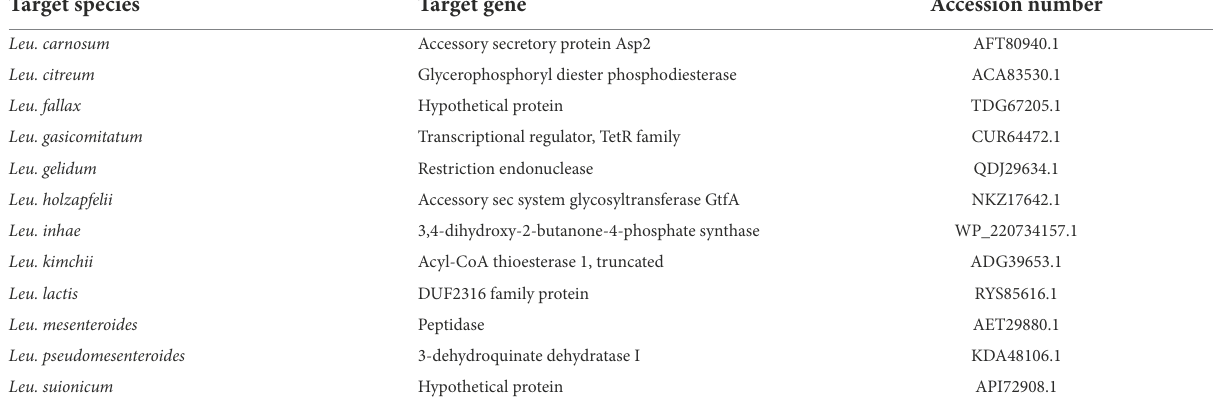
TABLE 1 Information of Leuconostoc species-specific genes obtained from pangenome